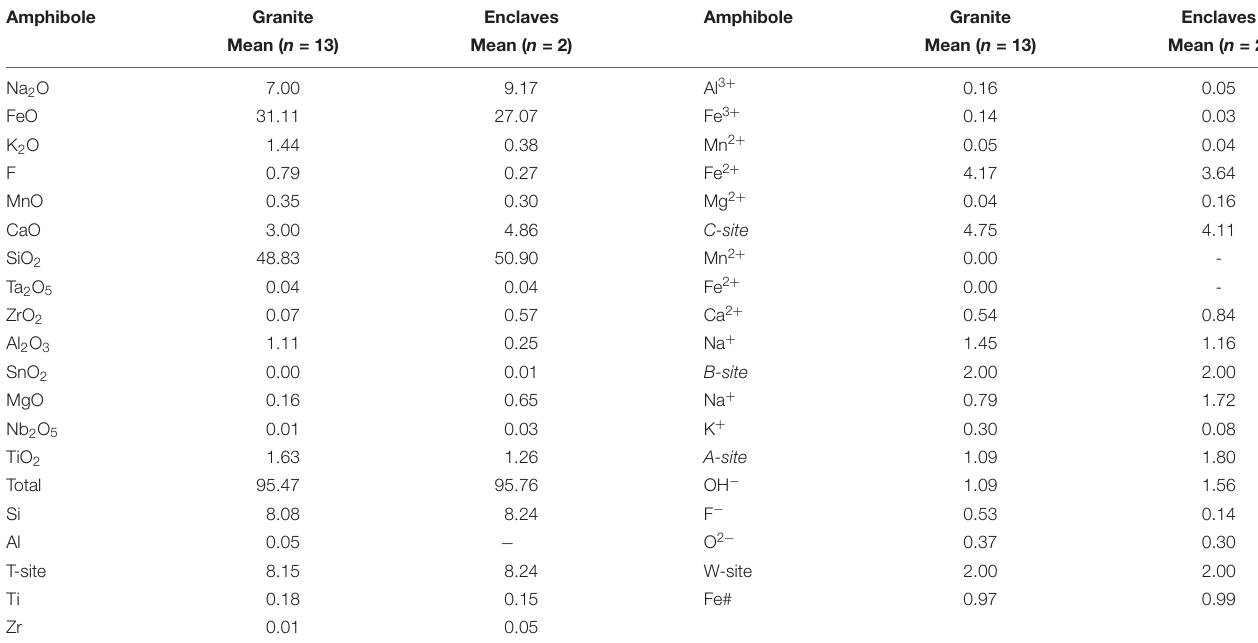
TABLE 1 | Major element contents of amphiboles from the host granite and enclaves. Amphibole Granite Enclaves Amphibole Granite